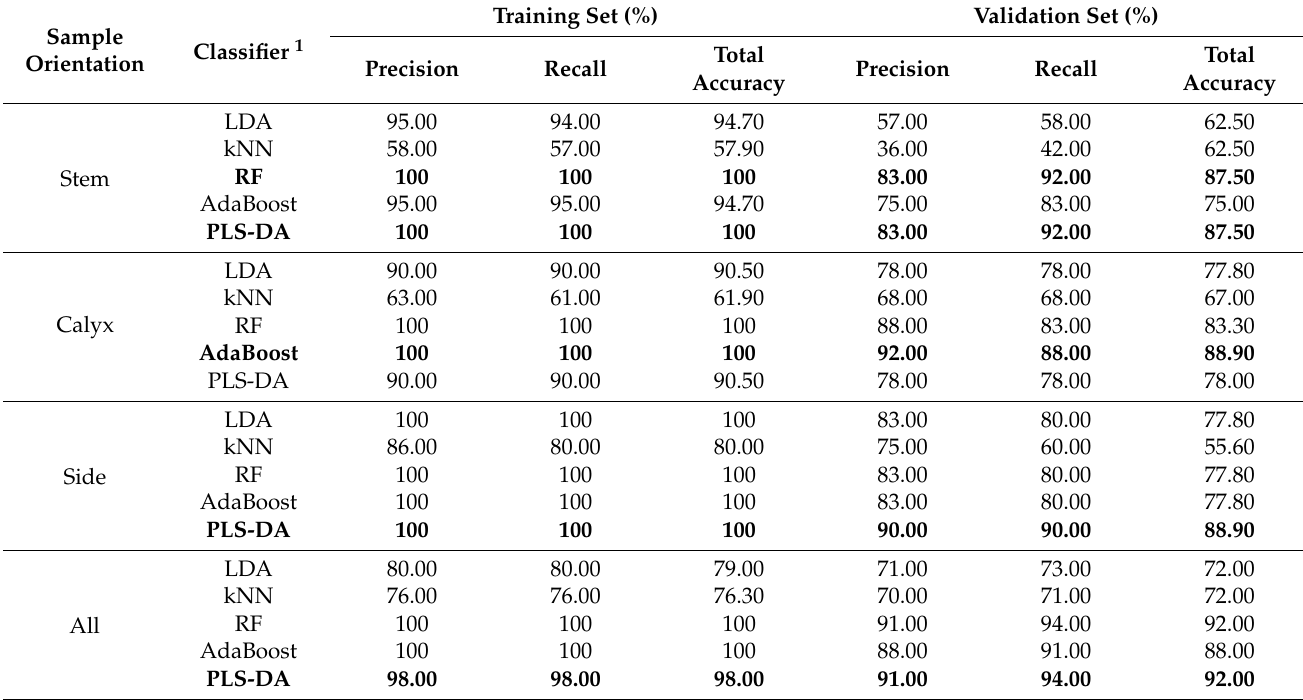
Table 1. Results of the PCA-based classification of control and infested samples for training and validation sets based on mean spectra for each sample.